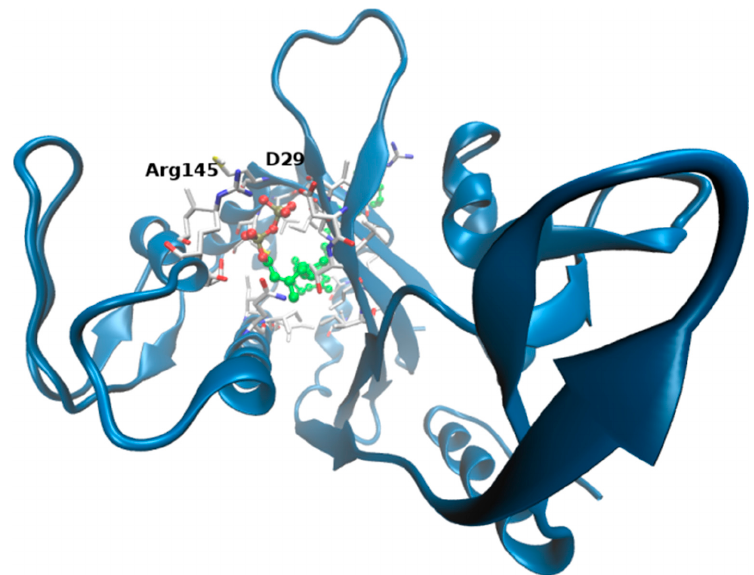
Figure 6. Docking models. Best ranked ligand pose predicted by SwissDock: Δ TM-FlmC is shown in blue cartoons, octaprenyl pyrophosphate in CPK and amino acids within 3 Å from the ligand in white sticks. Interacting residues at the top of the cavity are labelled (D29, R145). See main text.